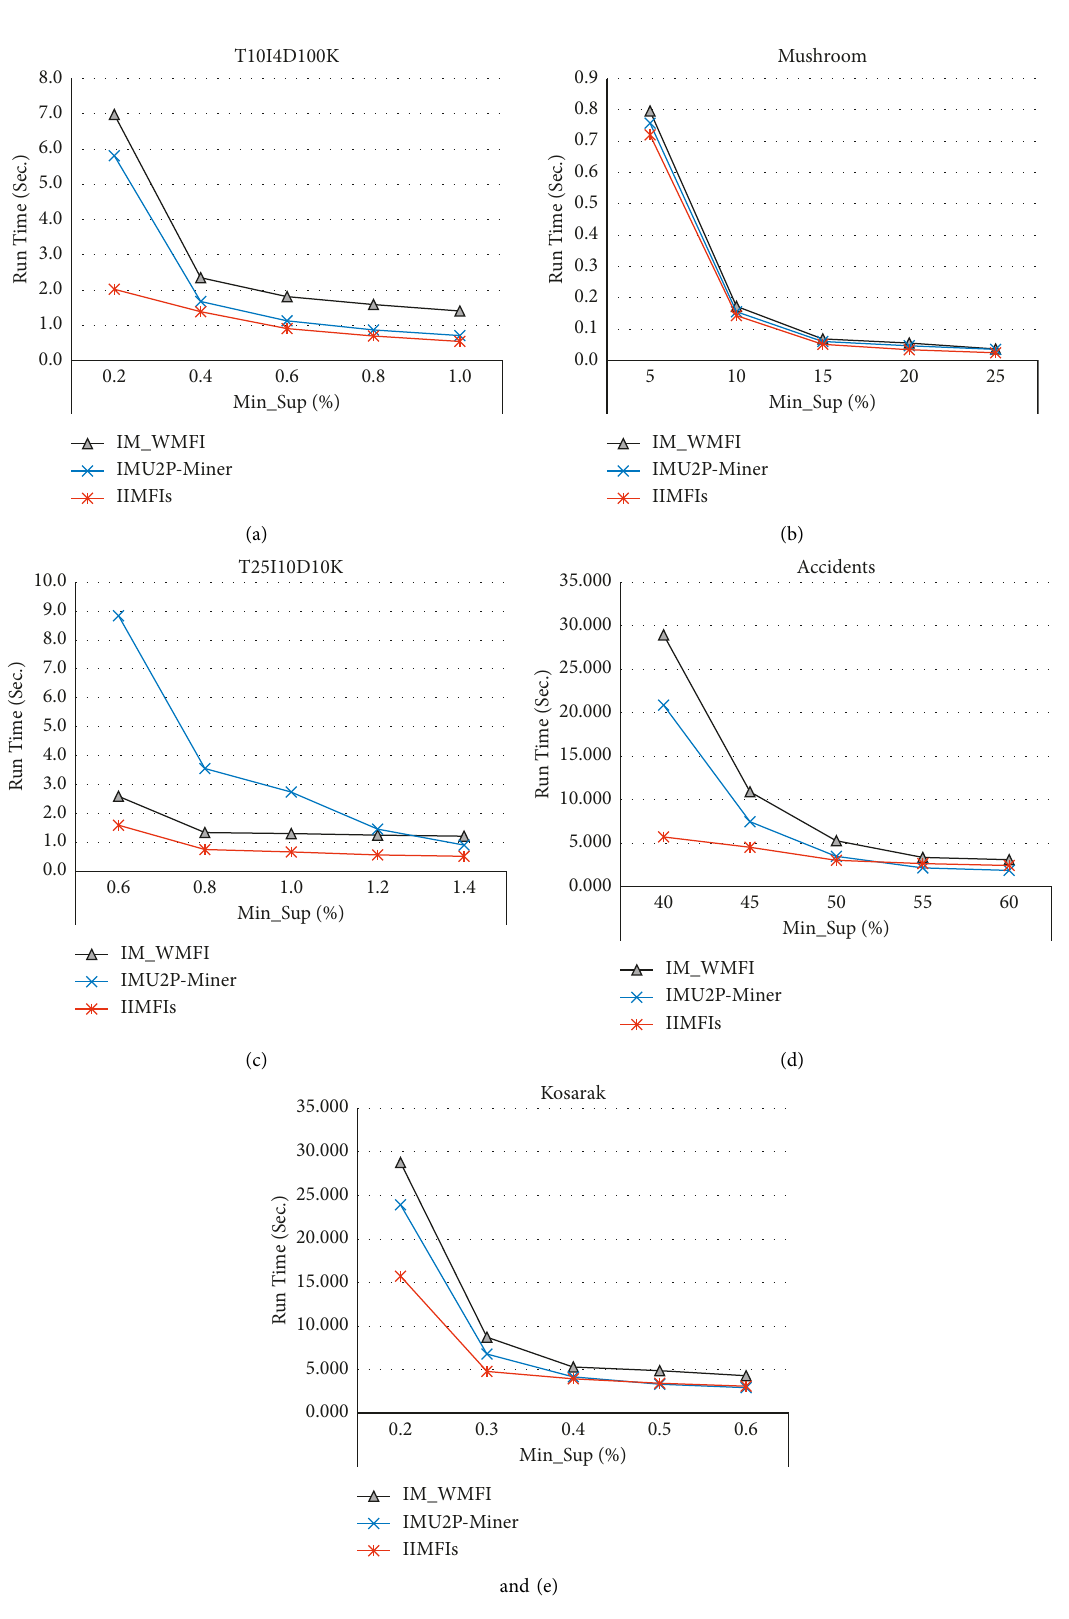
Figure 6: Comparing the total runtime of T1, T2, and T3 (Sec.) between IM_WMFI, IMU2P-Miner, and IIMFI algorithms on the datasets. (a) T10I4D100K, (b) Mushroom, (c) T25I100D10K, (d) Accidents, and (e)